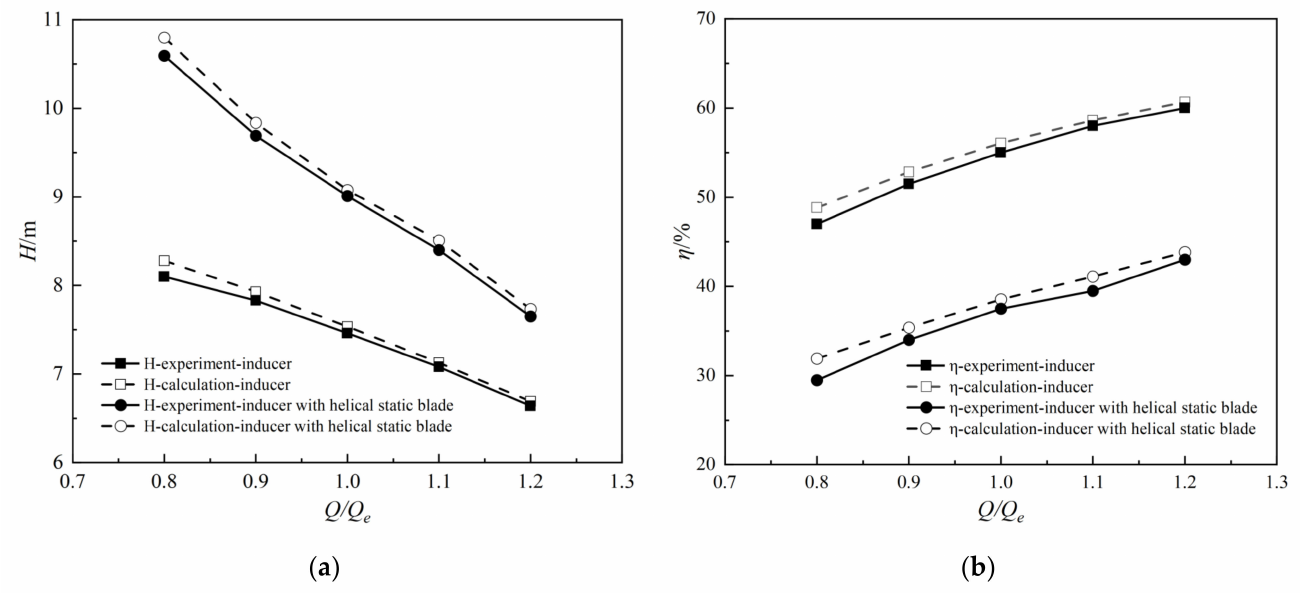
Figure 5. Results of numerical calculation and experiment. ( a ) Head. ( b )